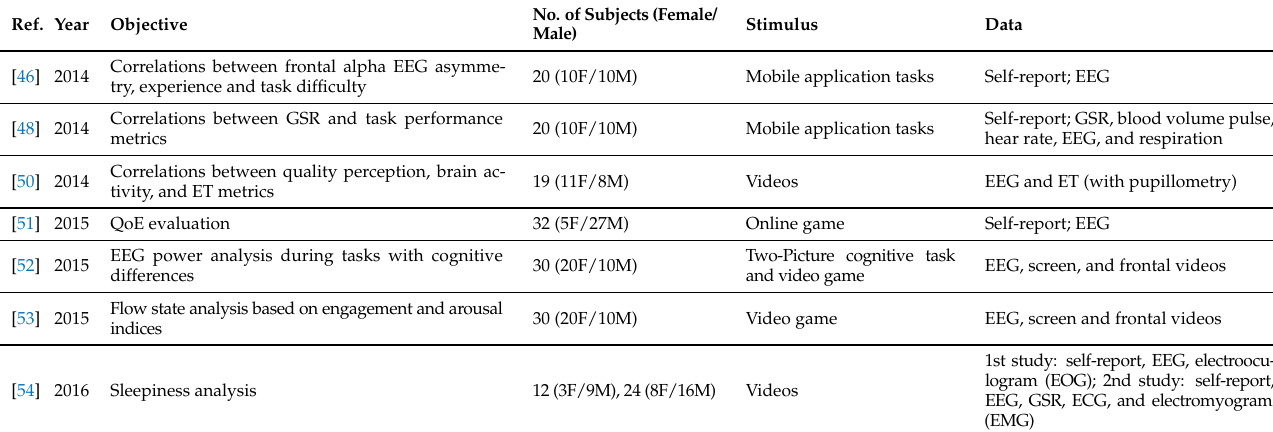
Table 3. Summary of research of correlations with cognitive states and QoE/UX